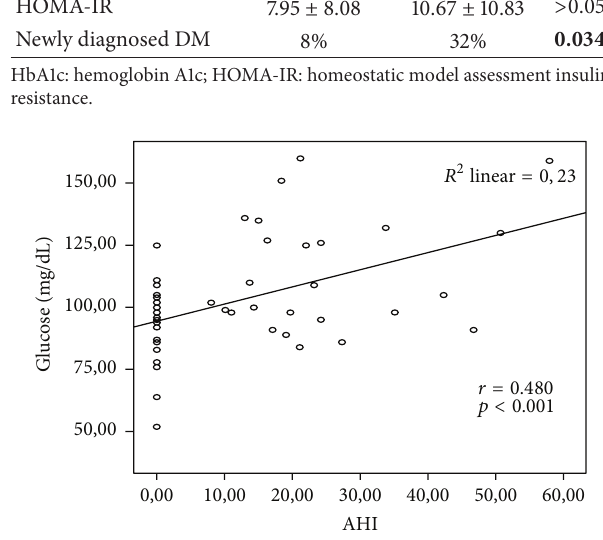
Figure 2: Pearson correlation analysis between AHI and